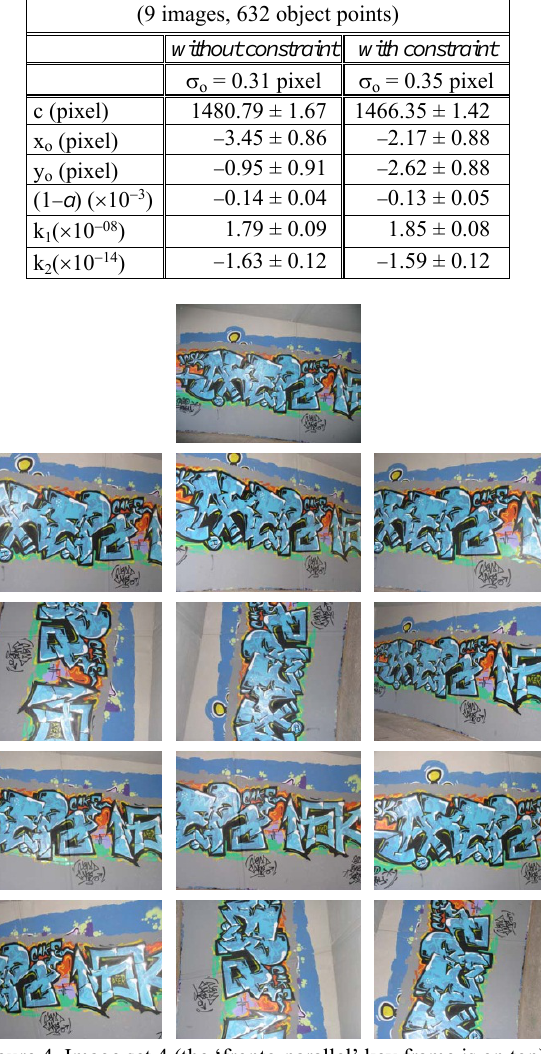
Figure 4. Image set 4 (the ‘fronto-parallel’ key frame is on